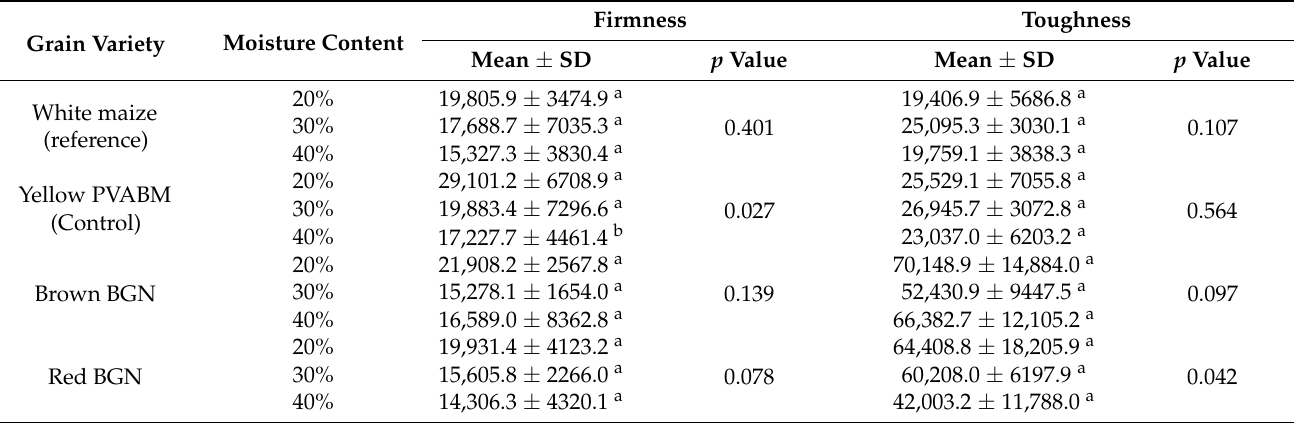
Table 3. The texture of the whole grains of white maize, yellow PVABM, brown and red BGN grain varieties [Newtons